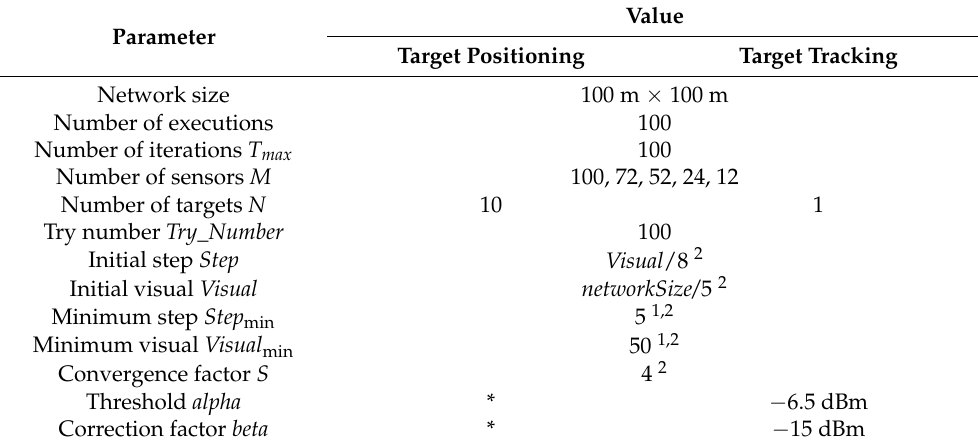
Table 3. AFSA parameters for target positioning and target